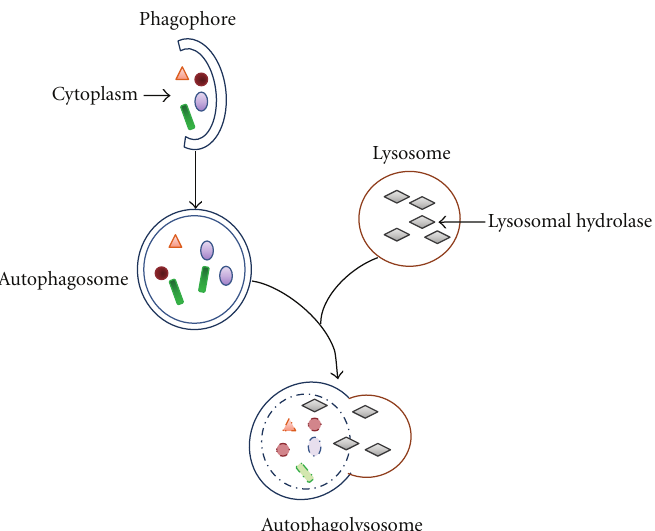
Figure 4: Schematic model of autophagy. First of all, a double membrane structure named autophagosome surrounds the target region and creates a vesicle which separates its contents from the rest of the cytoplasm. Secondly, the vesicle is transported and fused to the lysosome, forming autophagolysosome. Lastly, the contents are degraded by lysosomal